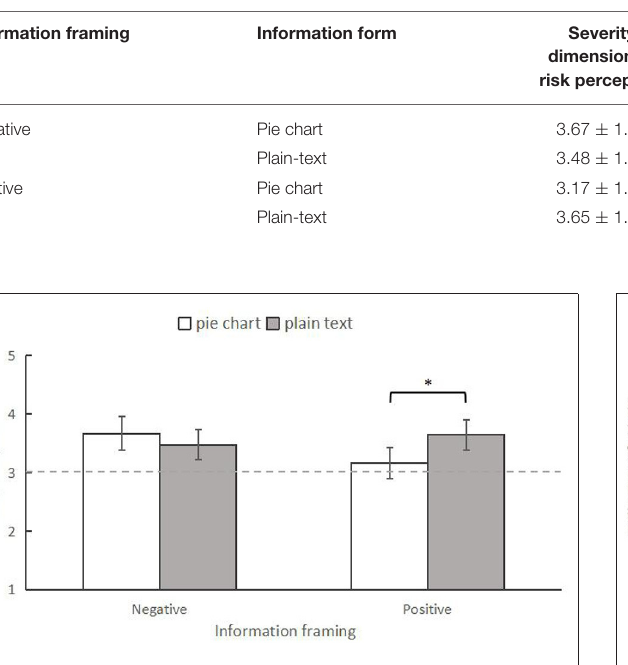
FIGURE 5 | The interaction between information frame and information form on willingness to help in Experiment 1. * p < 0.05 The error bars indicated 95%